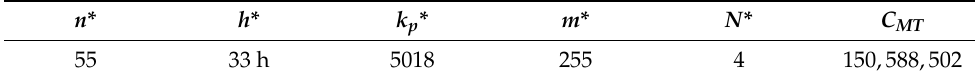
Table 17. Optimal control chart parameters.